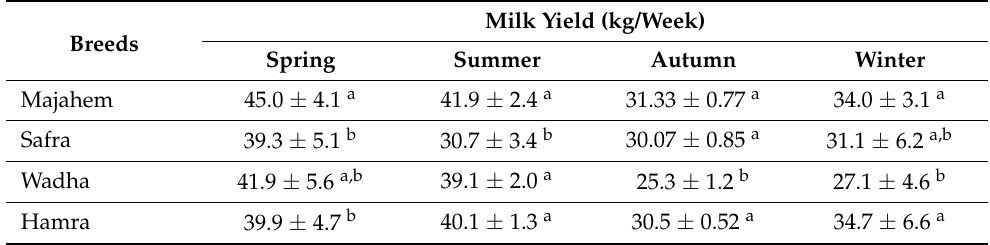
Table 1. Average milk yield (kg/week ± S.E.) of Saudi camel breeds during various seasons. Milk Yield (kg/Week) Breeds Spring Summer Autumn Winter Majahem 45.0 ± 4.1 a 41.9 ± 2.4